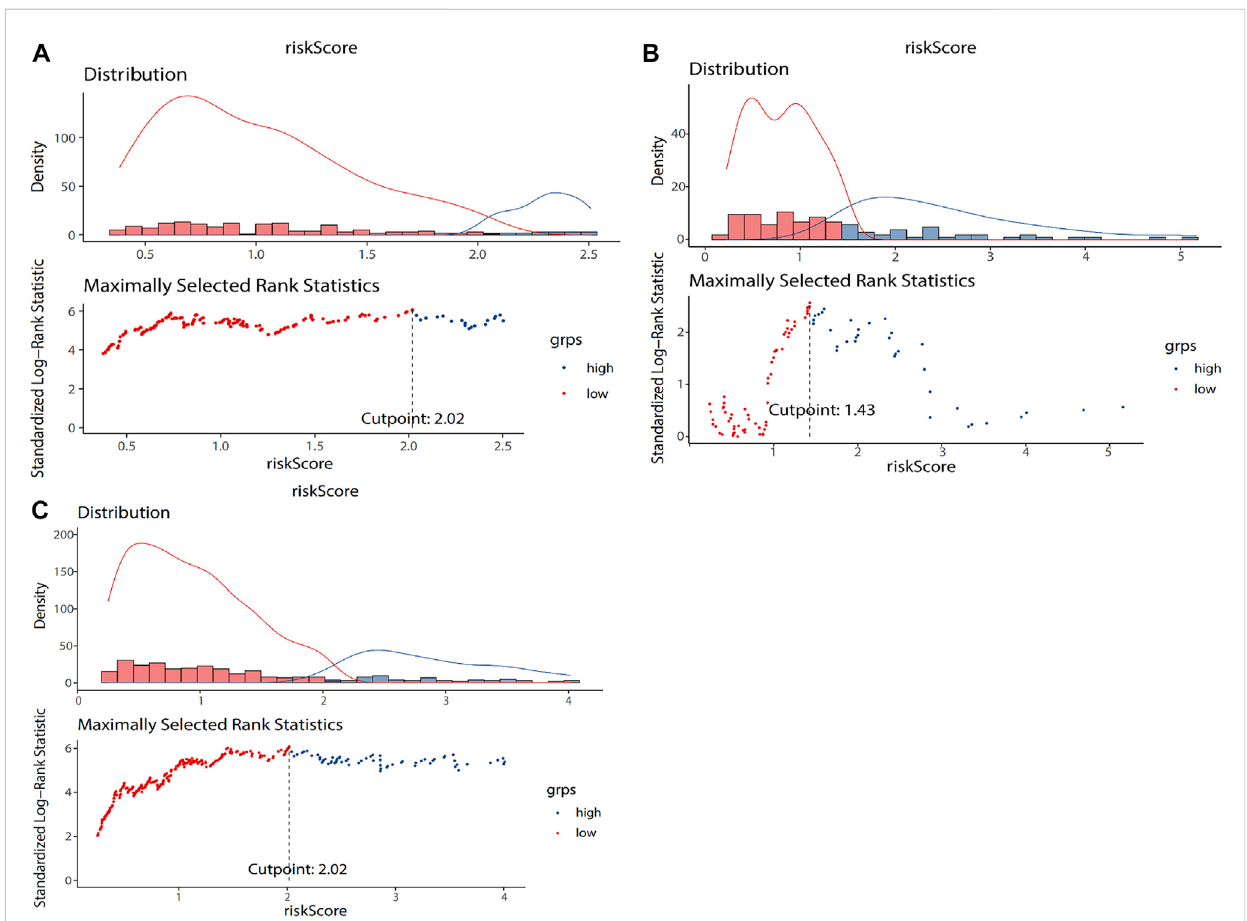
FIGURE 2 The grouping results of training dataset (A) , testing dataset (B) , and entire TCGA dataset (C) . The lower part of the fi gure is the optimal cut-off value calculatedaccordingtothemaximumselectionrankstatistics.Theriskscoreofthebluedotislowerthanthecut-offvalue,whichisalow-riskgroup.The risk score of the red dot is higher than the cut-off value, which is a high-risk group. The upper part of the fi gure is the data distribution histogram and density distribution curve of risk score. Blue represents low risk group, and red represents high risk